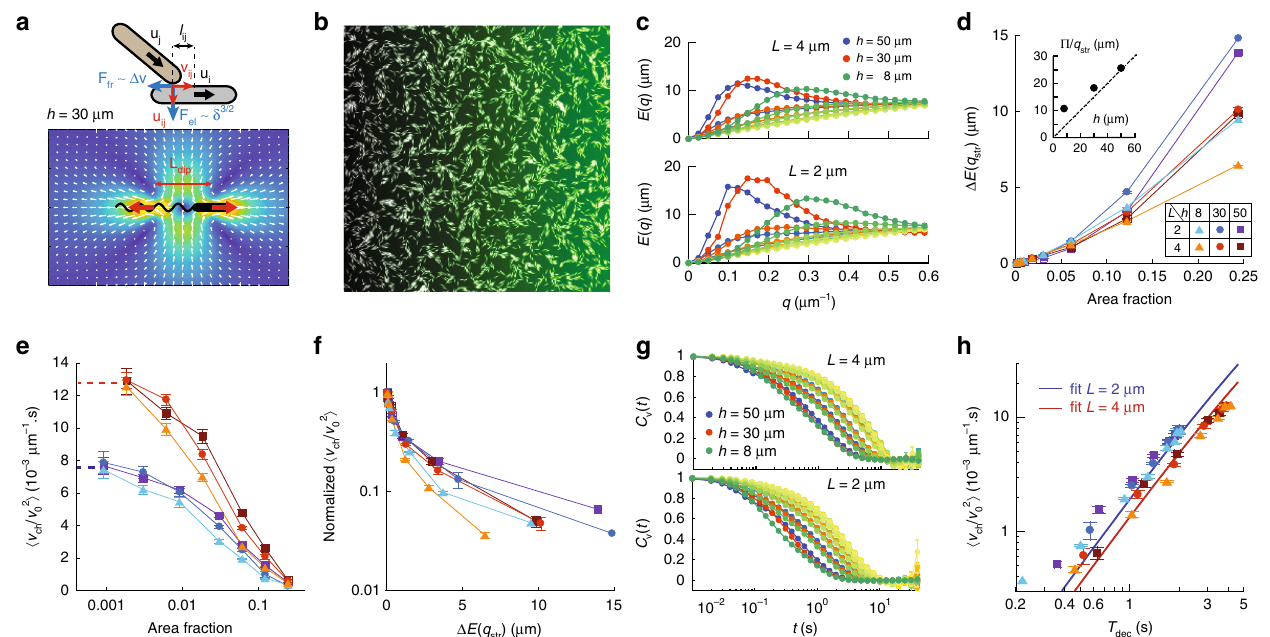
Fig. 4 Numerical simulations of self-propelled interacting chemotactic rods in 2D. a Schematic representation of the simulated steric interaction between the rods, where interpenetration ( δ ) results in Hertzian-like repulsion ( F ) and friction ( F ), and the fl uid fl ow generated by the hydrodynamic force dipole, el fr here for channel height h ¼ 30 μ m. For other heights, see Supplementary Fig. 6. b Snapshot of a simulation output (length L ¼ 4 μ m, h ¼ 30 μ m, Φ ¼ 0 : 244), showing collective motion of packs of rods. The green shading represents the gradient. c Flow structure factor E ð q Þ for indicated conditions, exhibiting a growing maximum at a q depending only on the channel height h . Darkening shading of a given colour indicates increasing area fraction in the str Þ , as a function of cell area fraction. (Inset) Typical vortex size π = q range 0 : 002 (cid:4) 0 : 25. d Maximum subtracted of its low-density value, Δ E ð q as a str str function of the channel height. Note the difference in scale compared to Fig. 2c. e Chemotactic coef fi cient as a function of the cell area fraction. Dotted lines represent its value in absence of interactions. f , Chemotactic coef fi cient, normalized to its low-density value, as a function of the maximum of the fl ow Þ . g Time autocorrelations of the cells velocity, the colour coding is the same as in ( c ). h Chemotactic coef fi cient as a function of the structure factor Δ E ð q str Þ ¼ 0 : 5, and fi t according to Eq. (4). d – f , h , Conditions are as indicated in panel d and error bars represent SEM decorrelation time τ , de fi ned by C v ð τ dec dec on at least 3 runs, totalizing at least 1000